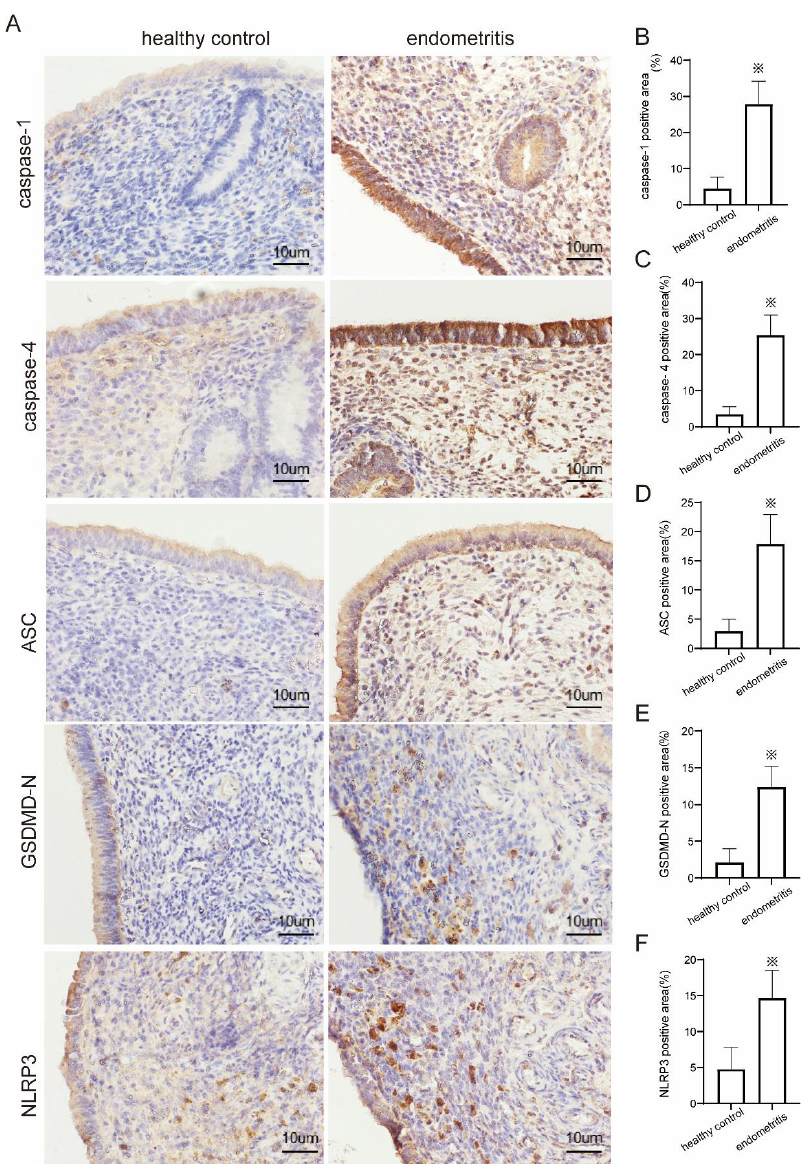
Figure 4. Immunohistochemical staining results of pyroptosis-related proteins in cow uterus. ( A ) Representative immunohistochemistry staining for caspase-1, caspase-4, ASC, GSDMD-N, and NLRP3 in cow uterine tissue classified as the healthy group ( n = 3) and the endometritis group ( n = 3); 400 × magnification. ( B ) The expression of caspase-1 in the treatment groups. ( C ) The expression of caspase-4 in the treatment groups. ( D ) The expression of ASC in the treatment groups. ( E ) The expression of GSDMD-N in the treatment groups. ( F ) The expression of NLRP3 in the treatment groups. The figures were analyzed using Image J. Values are presented as the mean ± SD. The experiment was conducted with the endometrial tissues of three healthy cows and the endometrial tissues of three cows with endometritis. ※ p <